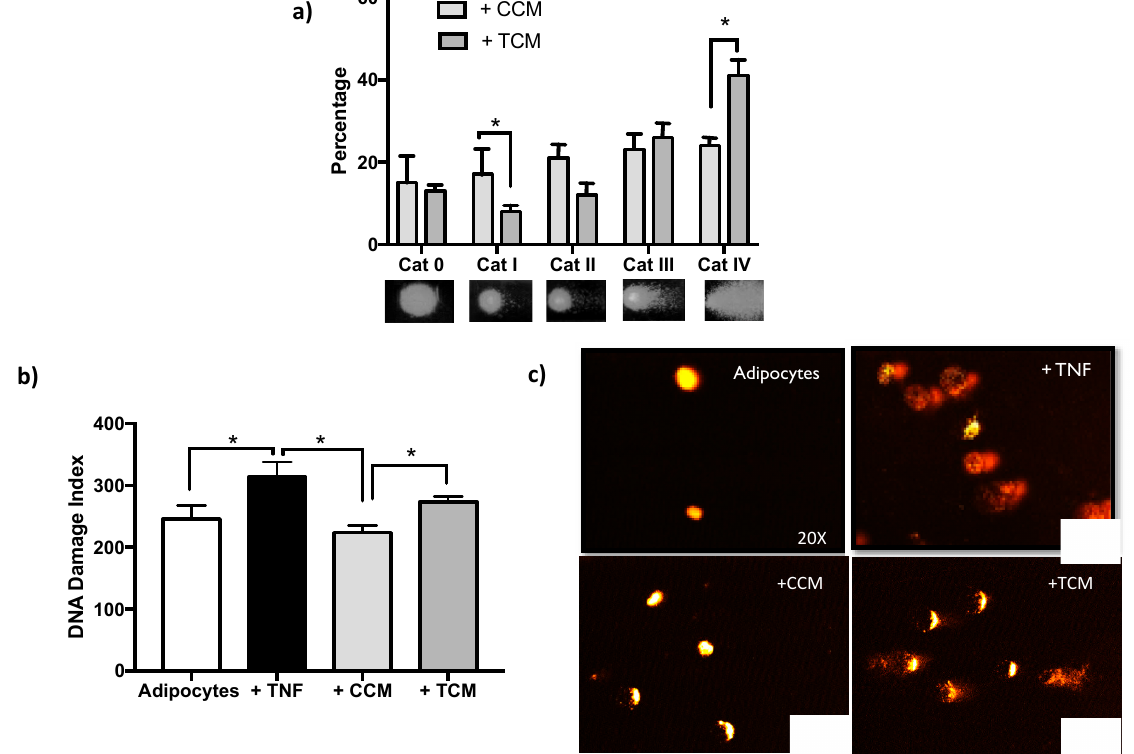
Figure 7. DNA damage persistent in Sustained DNA Damage Response (DDR). ( a ) Increase of the percentage distribution of DNA damage categories (Cat 0 less damage to Cat IV higher damage), after adipogenesis with Treated (TNF α ) Conditioned Medium (+ TCM), three independent experiments were carried out. Two-way ANOVA test * p < 0.05. ( b ) The DNA damage index increases after adipogenesis in TCM relative to differentiation in CCM. The comparison shown including the basal damage of the adipocytes and adipocytes treated with TNF α from which the conditioned media come from (ANOVA multiple comparison analysis, * p < 0.05). ( c ) DNA damage images representatives of comet assay, acquired with Komet V5.0.